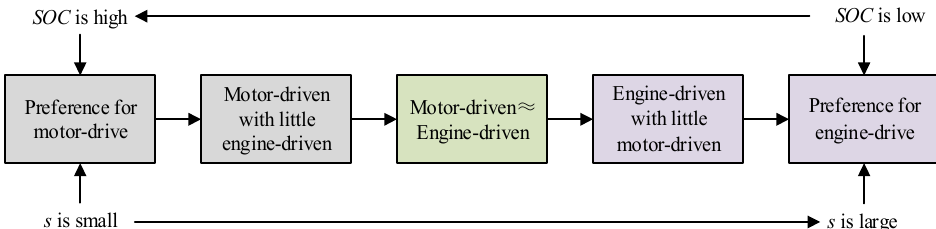
Figure 11. Logical relationships of equivalence factor and SOC .